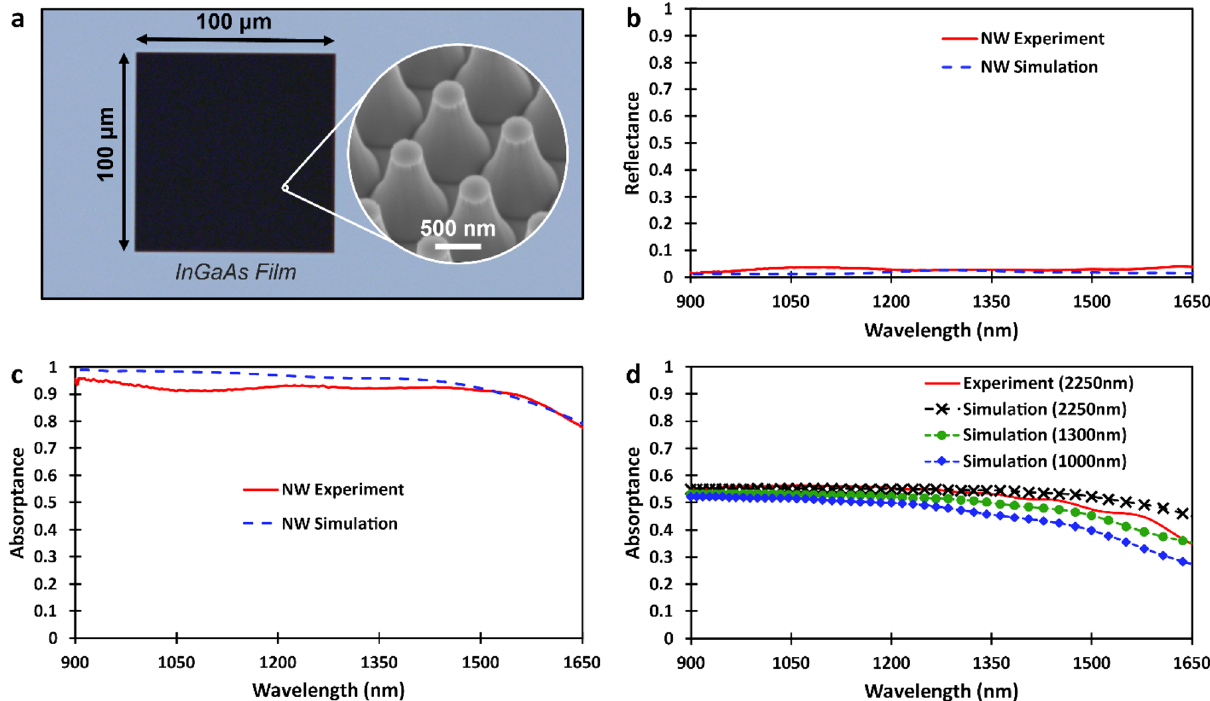
Figure 4. Near-unity nanowire metamaterial absorption. ( a ) Optical microscope image of the fabricated InGaAs tapered nanowire metamaterial (black square) on an InGaAs film (blue-grey). The lack of contrast in the 100 μm × 100 μm active area is indicative of high absorption. The inset shows a scanning electron micrograph of tapered InGaAs nanowires that is representative of the selected area from the high absorbing metamaterial region. ( b ) Comparison of the simulated and experimentally measured reflectance for the nanowire metamaterial as a function of wavelength. The fabricated (modelled) nanowire metamaterial dimensions are similar with a top radius: 175 nm (170 nm), bottom radius: 440 nm (441 nm), height: 1300 nm (1400 nm), and a pitch: 900 nm (900 nm). ( c ) Comparison of the simulated and experimentally measured absorption spectra of an InGaAs tapered nanowire metamaterial with the same dimensions as ( b ), which demonstrates the near-unity absorption over an unprecedented wavelength range. The measured (simulated) average absorption efficiency from 900 to 1500 nm is 93% (97%). ( d ) Measured and calculated absorption spectra of a planar InGaAs film on an InP substrate for various thicknesses—measured film: 2250 nm; modelled films: 1000 nm, 1300 nm, and 2250